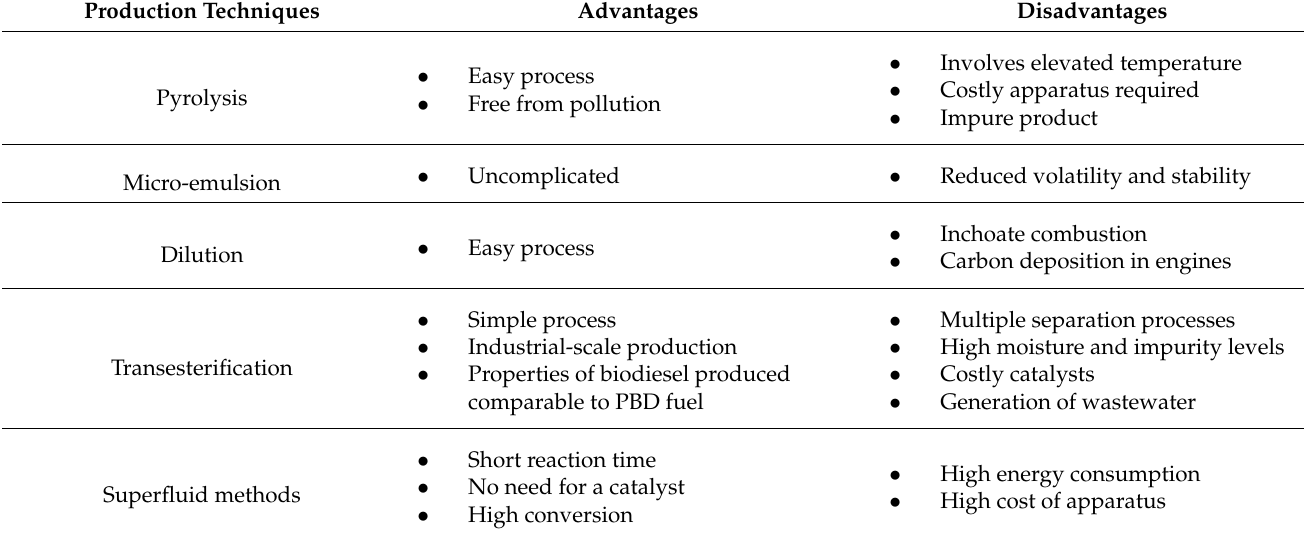
Table 5. Advantages and disadvantages of various biodiesel production